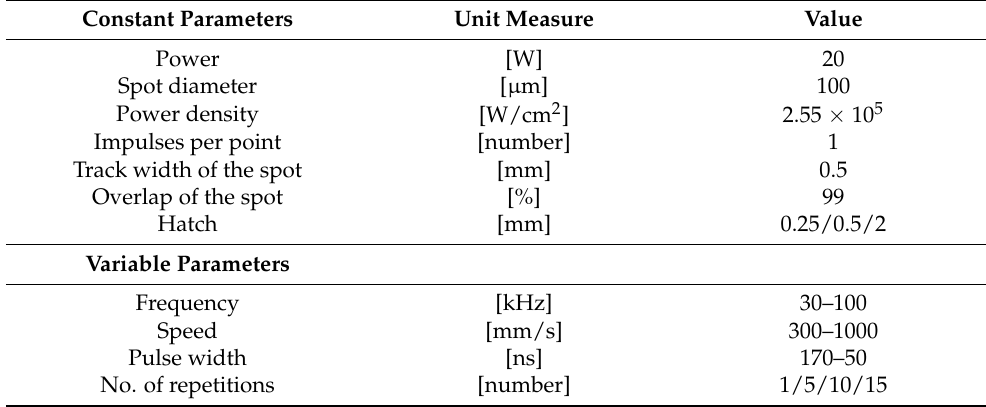
Table 2. Variable and constant parameters for applied LST pattern on AISI 430 stainless